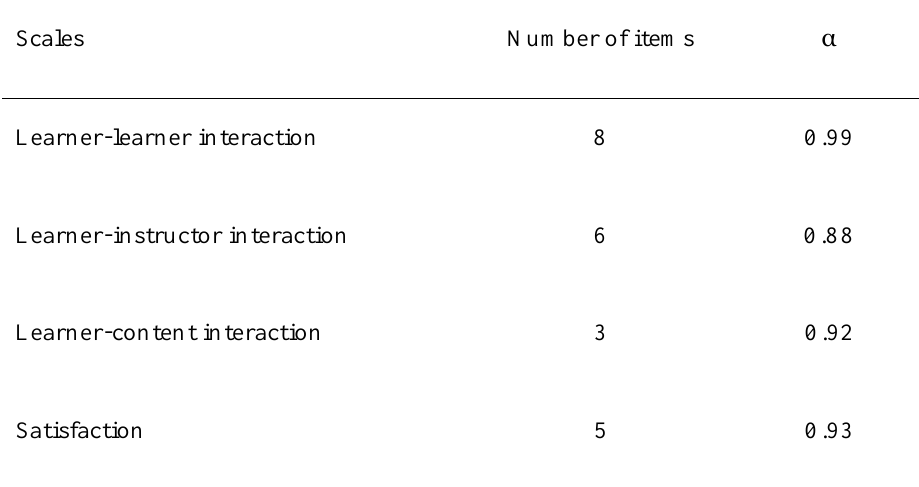
Reliability Information for